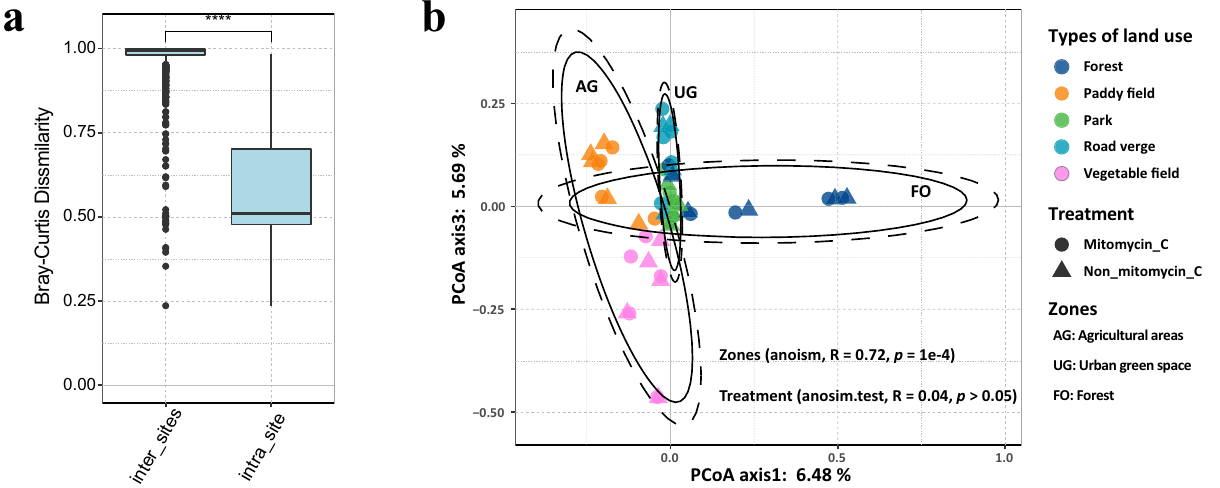
Fig. 2 | The macrodiversity of soil viral communities. a Boxplot showing Bray – Curtis dissimilarity of viral communities of intra-sites (between the cor- responding community of iVLPs and eVLPs, n =25) and inter-sites (between differentsamplesites, n =300).Theminima, maxima, center,boundsofboxand whiskersinboxplotsfrombottomtotoprepresentedpercentile0,10,25, 50,75, 90, and 100, respectively, the difference between different zones was tested using the two-sided Wilcox.test, **** p <0.0001. The exact p value is 1.6e-15. b Principalcoordinatesanalysis(PCoA)ofviralcommunitystructures,asderived fromreadsmappingto59,626vOTUsandBray – Curtisdissimilarities;eachpoint